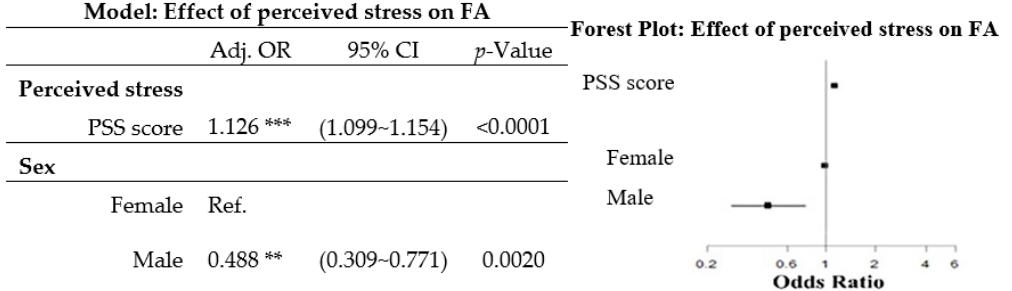
Figure 1. Odds ratio (OR) of food addiction (FA) for perceived stress after adjusting for sociodemographic characteristics 1 . 1 The model was obtained from a multiple logistic regression, and was adjusted for age group, employment status, and educational attainment. ** 0.0001 ≤ p -value ≤ 0.01, *** p -value < 0.0001. PSS, Perceived Stress Scale; Adj. OR, adjusted odds ratio; CI, confidence interval; Ref., reference.